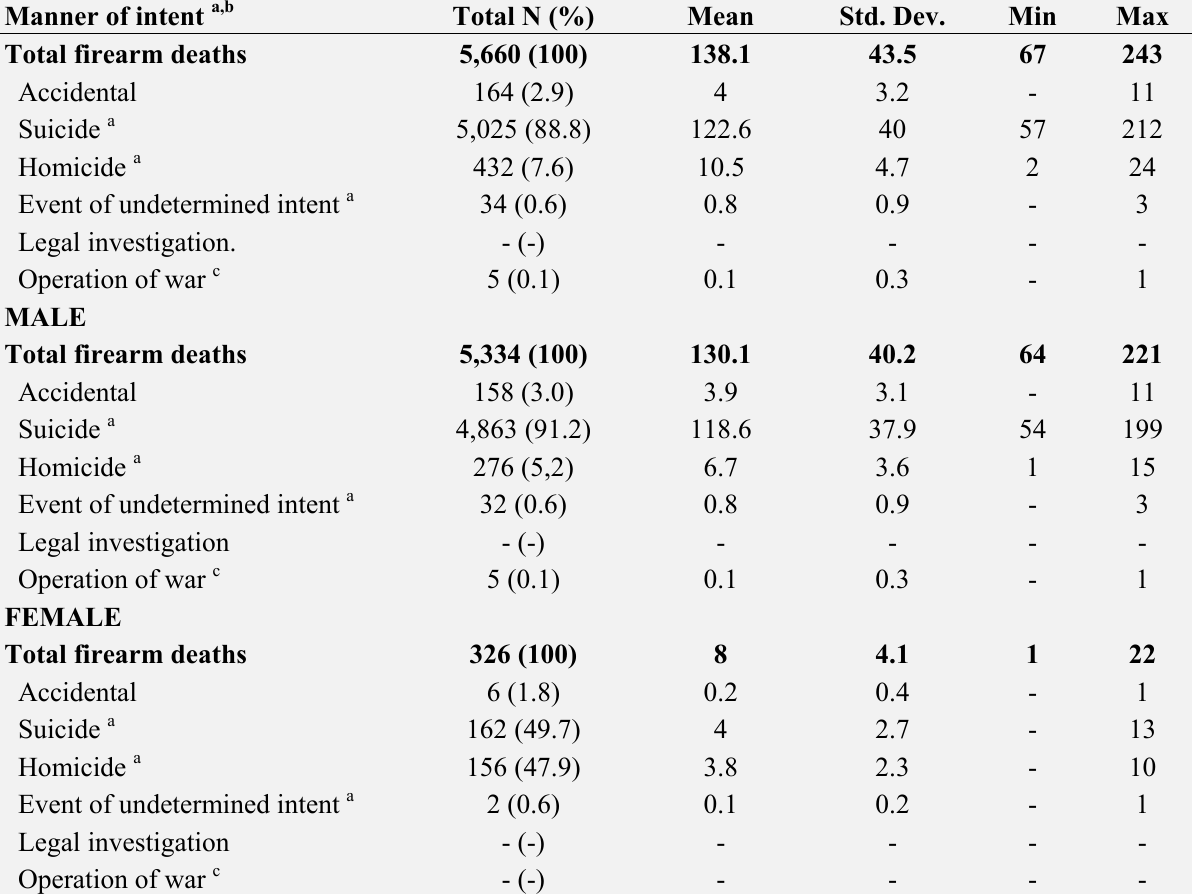
Table 3. Summary of fatal firearm injuries 1969–2009 by manner of